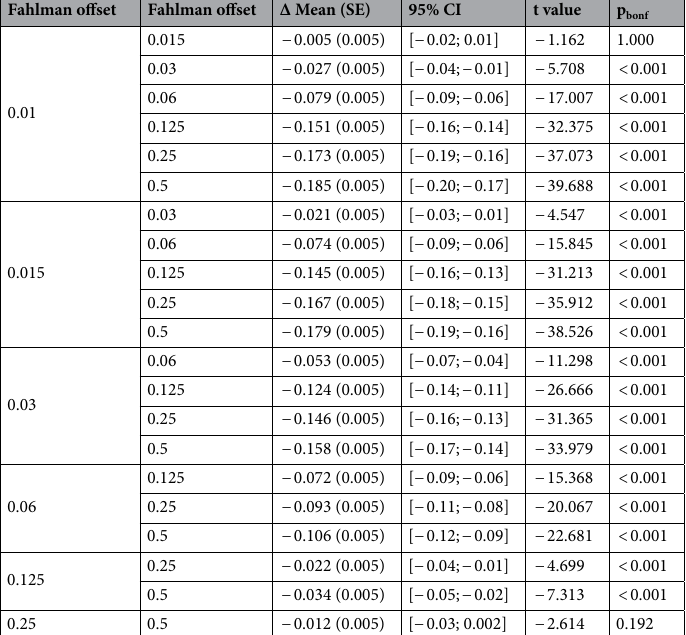
Table 4. Within-subjects effects of the clock plasticity parameter (Fahlman offset